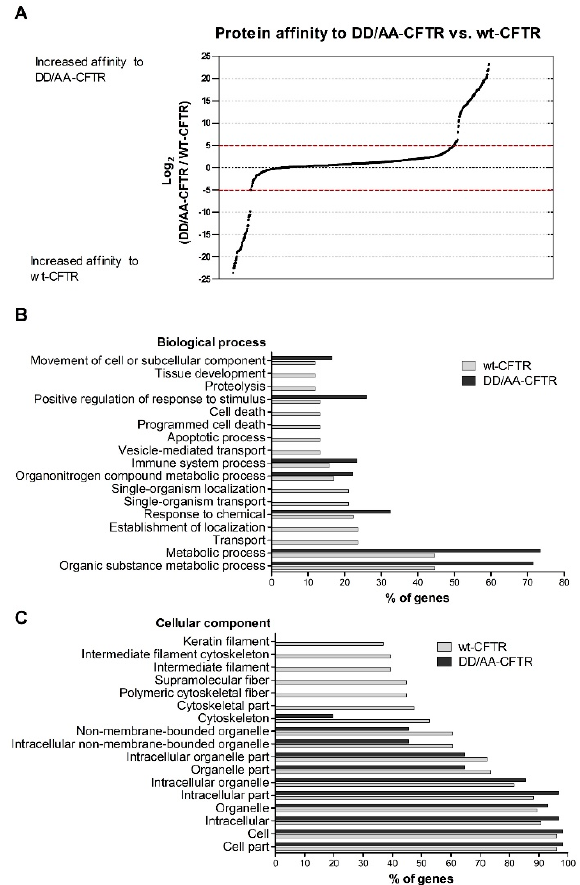
Figure 1. Differential protein interactions detected for DD/AA-CFTR versus wt-CFTR. ( A ) Log 2 plot of the protein abundance ratio for DD/AA-CFTR versus wt-CFTR. Proteins were identified by LC-MS/MS, and black dashed lines indicate the threshold (log 2 = ±5). Experiments were performed in triplicate (N = 3). GO analysis for differential interactors of DD/AA- versus wt-CFTR. ( B ) Biological process and ( C ) cellular component represented for DD/AA-CFTR and wt-CFTR using Database for Annotation, Visualization and Integrated Discovery (DAVID). From the total of 1150 proteins, the 161 with more affinity to DD/AA-CFTR and the 77 with more affinity to wt-CFTR were used to find the GO term biological process enriched in both subsets. p -value < 0.05.